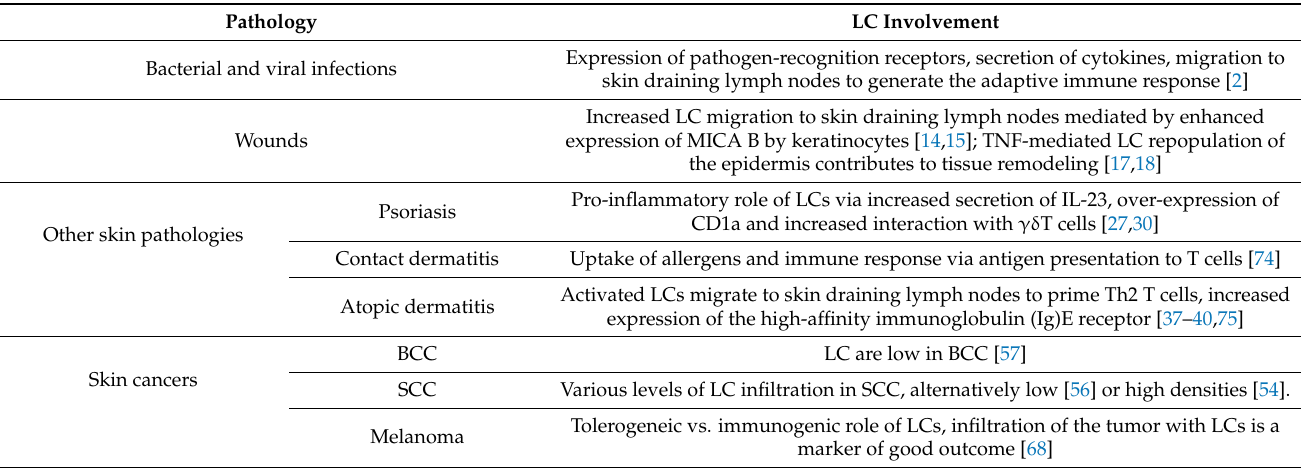
Table 1 outlines the major involvement of LCs in skin pathologies. Table 1. LC involvement in skin